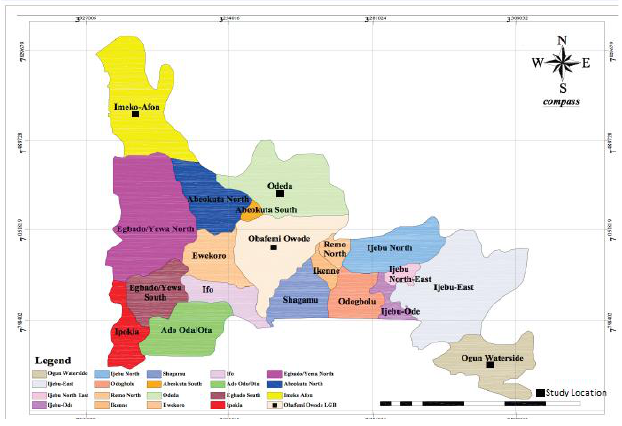
Fig. 1. Ogun state map of Nigeria, showing the study area [15]